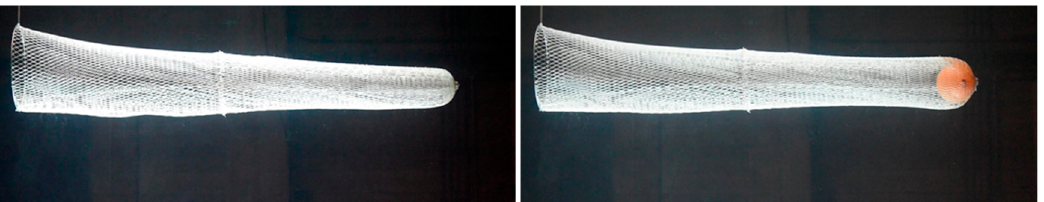
Figure 3. Side-view of the empty codend ( left ) and codend with catch ( right ) in the flume tank.